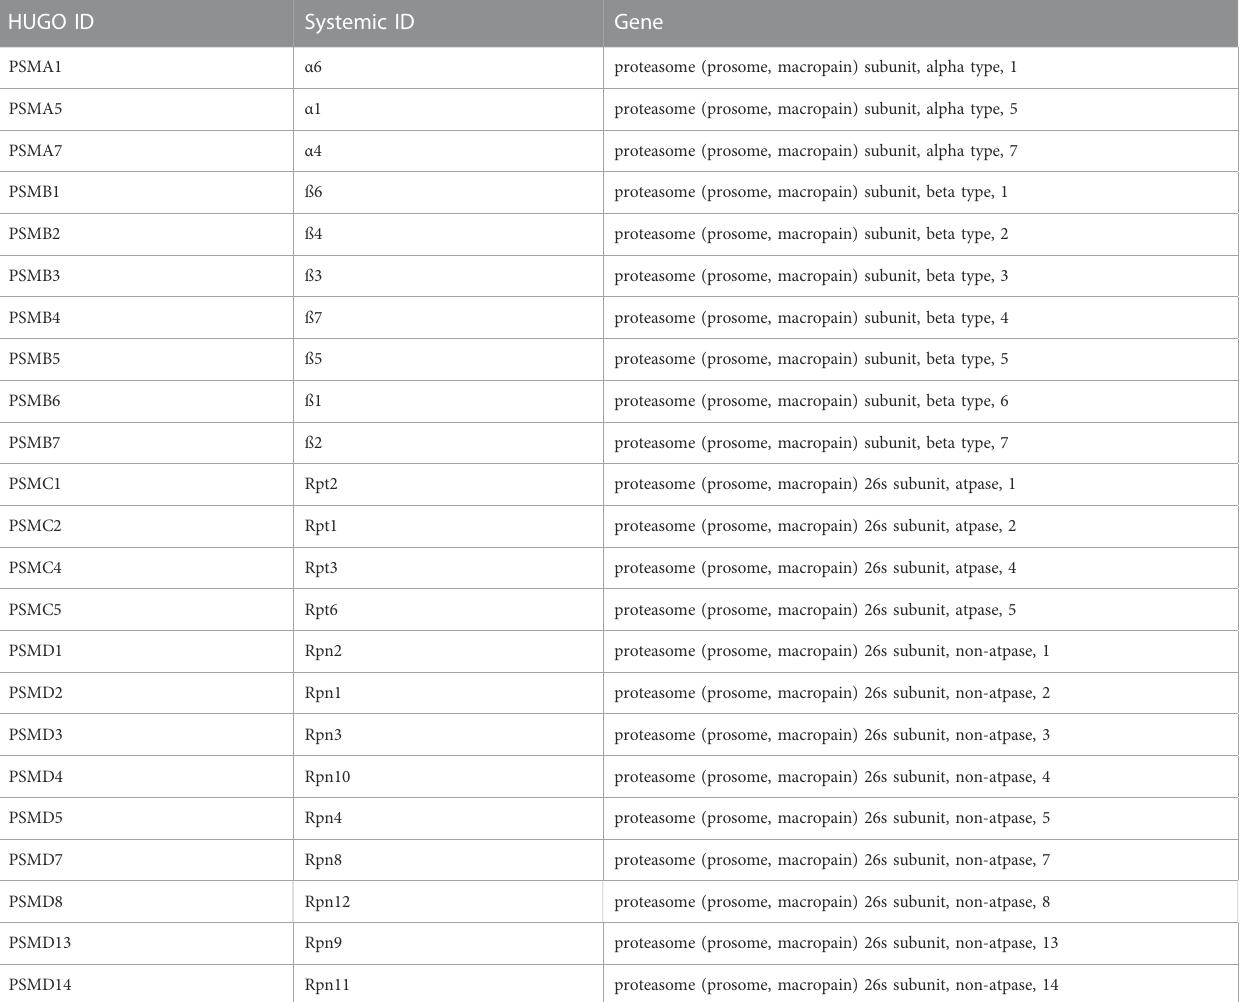
TABLE 1 List of DEGs belonging to the proteasomal degradation pathway identi fi ed in the GO enrichment analysis (GO:2000736). HUGO ID Systemic ID